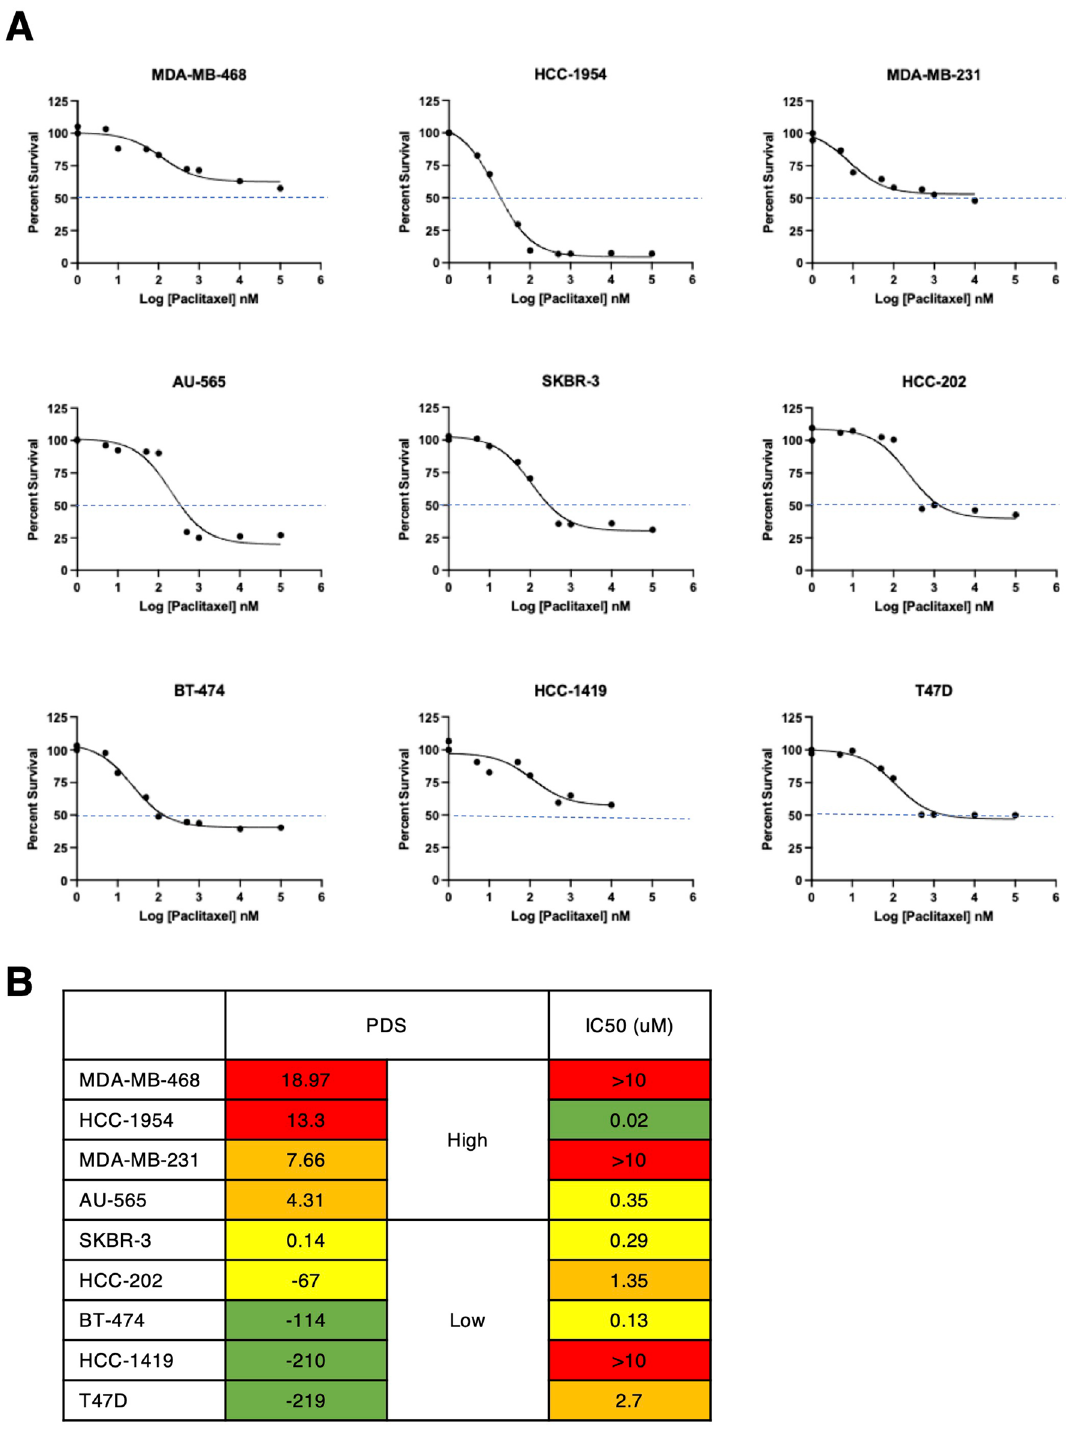
Figure 3. Drug sensitivity in breast cancer cell lines. ( A ) The indicated breast cancer cell lines were plated into 96-well plates and were treated with various concentrations of paclitaxel. MTS assays were performed following a 48-h incubation with paclitaxel. ( B ) PDSs and paclitaxel IC50’s are shown for each breast cancer cell